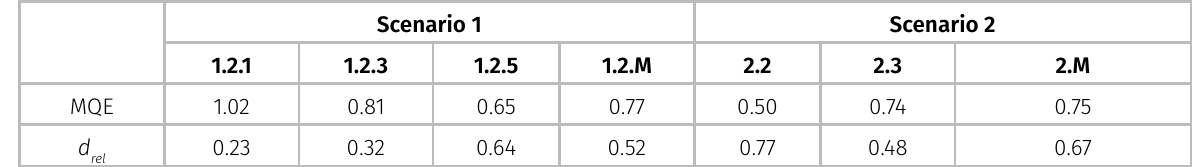
Table VII. Mean Quadratic Error (MQE), in L/s.km 2 , and Willmott relative coefficient ( d assessed.